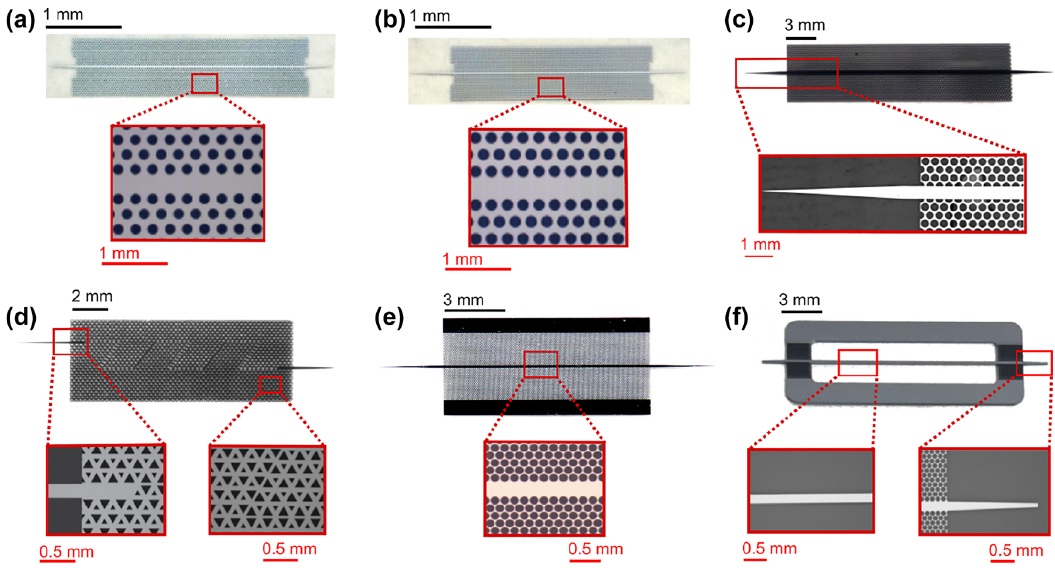
Figure6: Planarall-Siwaveguideplatformsandrespectivesimulatedfielddistribution,(a)photoniccrystalwaveguidewithequilaterallattice [108],(b)photoniccrystalwaveguidewithisosceleslattice[108],(c)Bragg-mirrorsuppressedwaveguide[34],(d)topologicalwaveguide[109], (e) EM waveguide [24], (f) unclad waveguide [25].